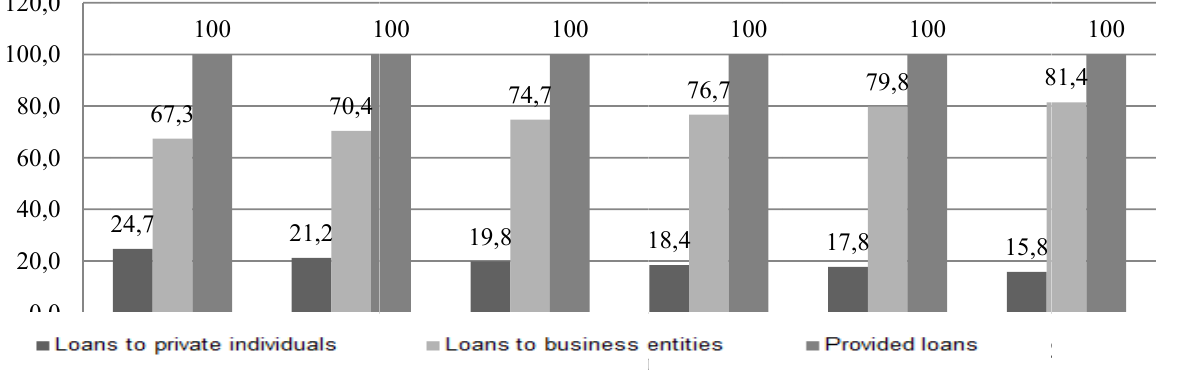
of the banks in formation of Na signi ucture and p estore affec antial their The tions Ukra